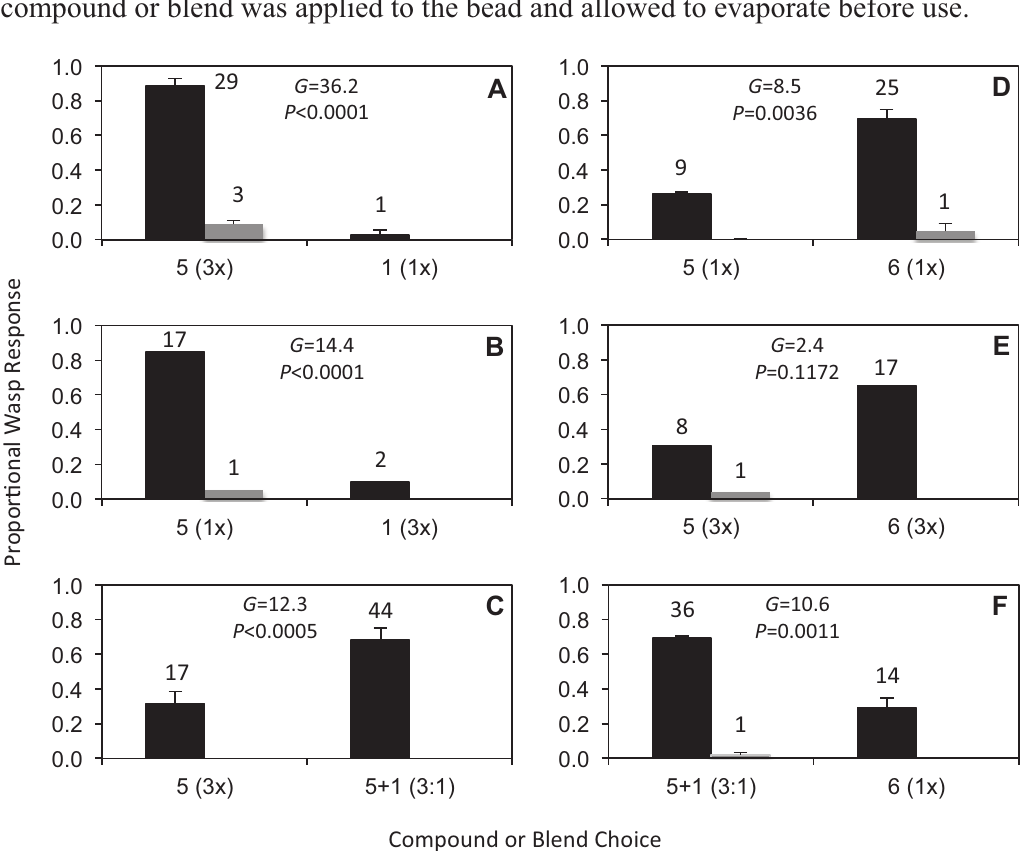
Figure 2. Responses of male Catocheilus wasps to bioassays presenting choices of compounds 1 , 5 and 6 in different combinations and at different concentrations. The wasp responses are shown as proportions of the total, further partitioned into approach (black) versus combined land and attempted copulation (grey). The number of wasps responding to each treatment and the outcomes of G -tests for the null hypothesis of no difference between the two choices, based on the total number of responses, are also shown. ( A ) Compounds 1 versus 5 with 5 at 3-fold higher concentration. ( B ) Compounds 1 versus 5 with 1 at 3-fold higher concentration. ( C ) Compound 5 versus a blend of 5 and 1 at a 3:1 ratio. ( D ) Compound 5 versus 6 at equal 1-fold concentration (1×). ( E ) Compound 5 versus 6 at equal 3-fold higher concentration (3×). ( F ) Compound 6 versus a blend of 5 and 1 at a 3:1 ratio. For experiments A , C , D and F , proportions are shown as means ±se, each calculated across two replicate experiments. For the 1× concentration 3 μL of a 10 (cid:2)g/(cid:2)L solution of the compound or blend was applied to the bead and allowed to evaporate before